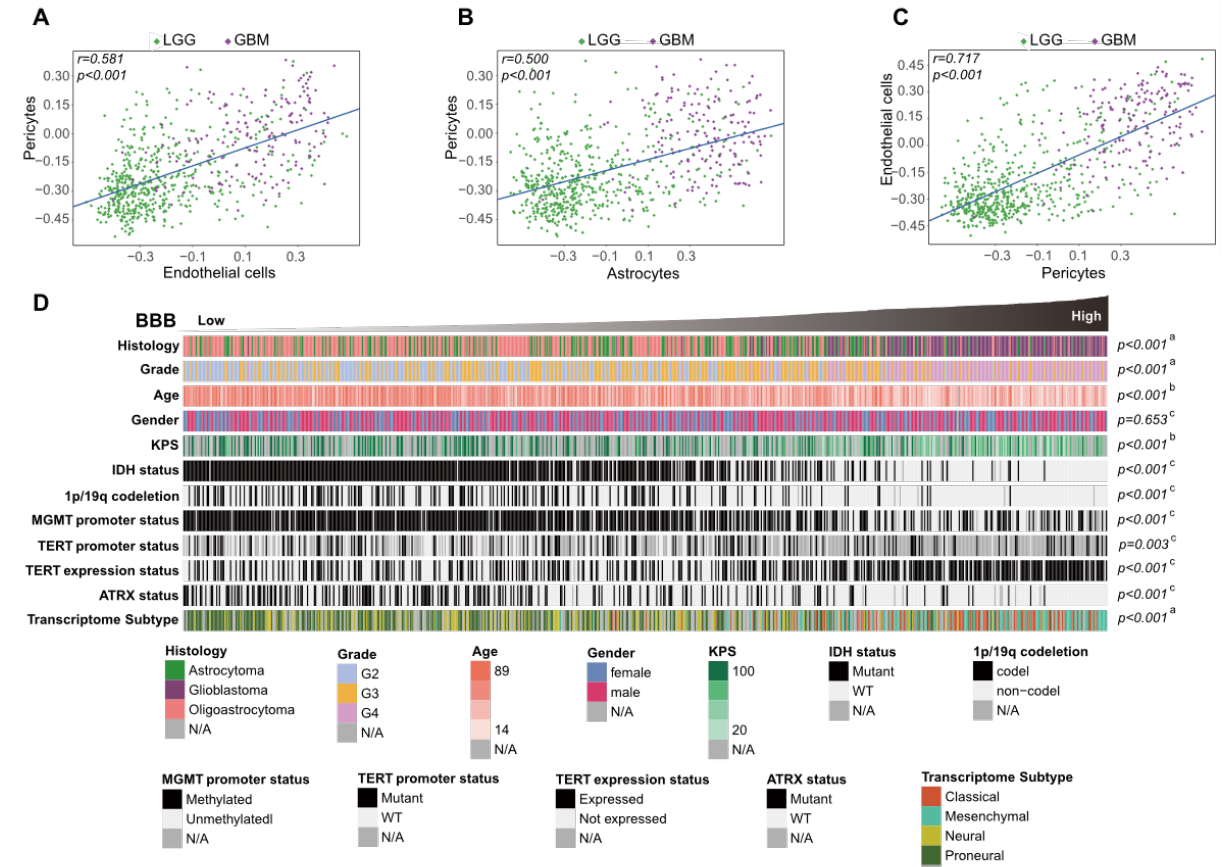
Figure 2. Correlation of GSVA scores between BBB constituent cells ( A – C ). Glioma patients in the TCGA cohort were arranged in order of increasing BBB score ( D ), and the relationships between different patient characteristics and BBB score was evaluated (a, The distribution of BBB scores among several groups was assessed using one-way ANOVA. b, The associations between BBB score and continuous variables was assessed using Spearman correlation tests. c, The distribution of BBB scores between two groups was assessed using Student’s t test).